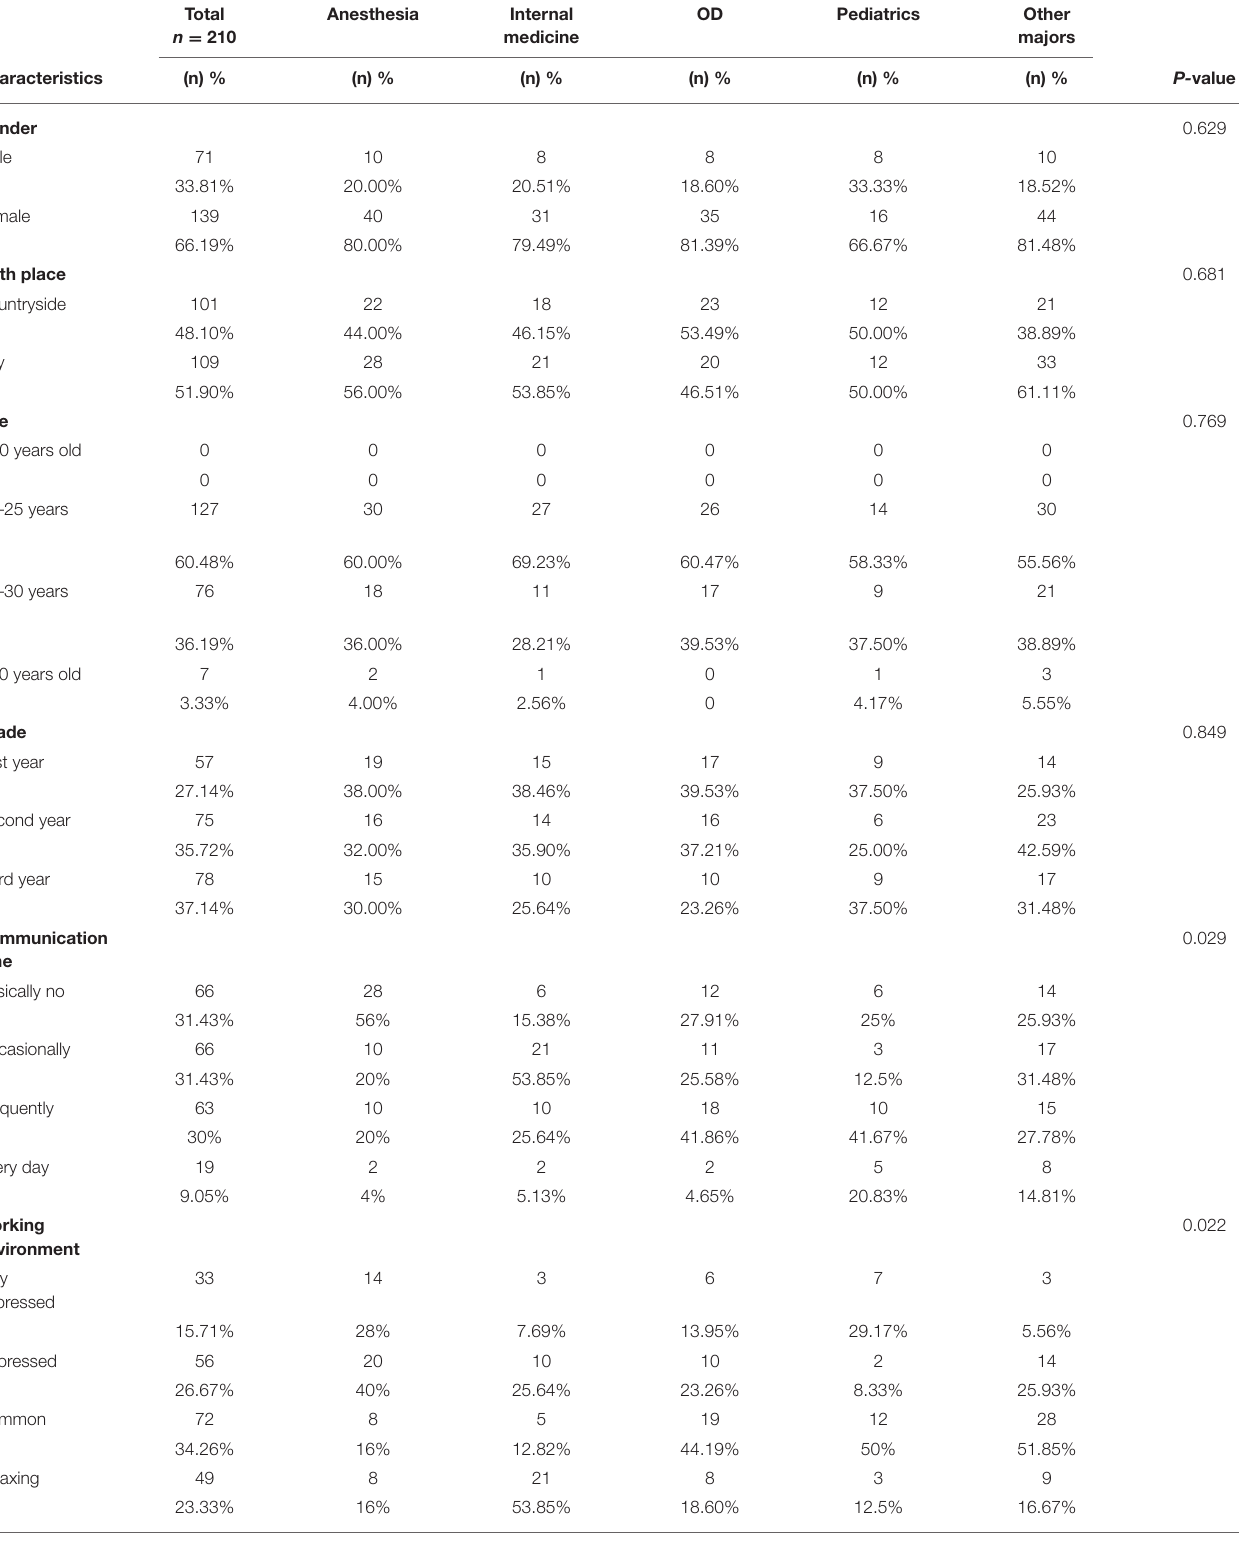
TABLE 1 | The demographics among different